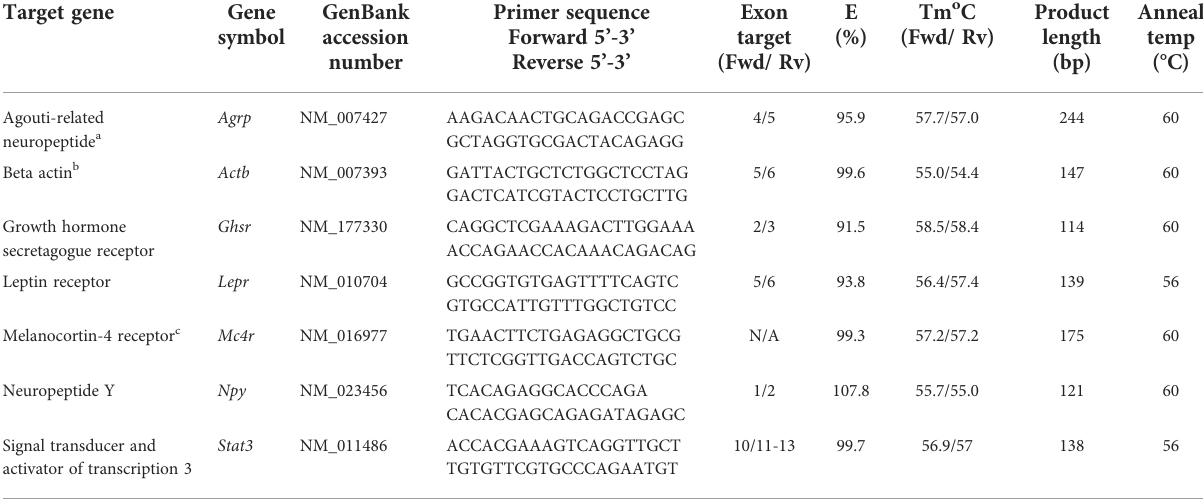
TABLE 1 RT-qPCR primer sequences and ef fi ciencies and PCR products. Target